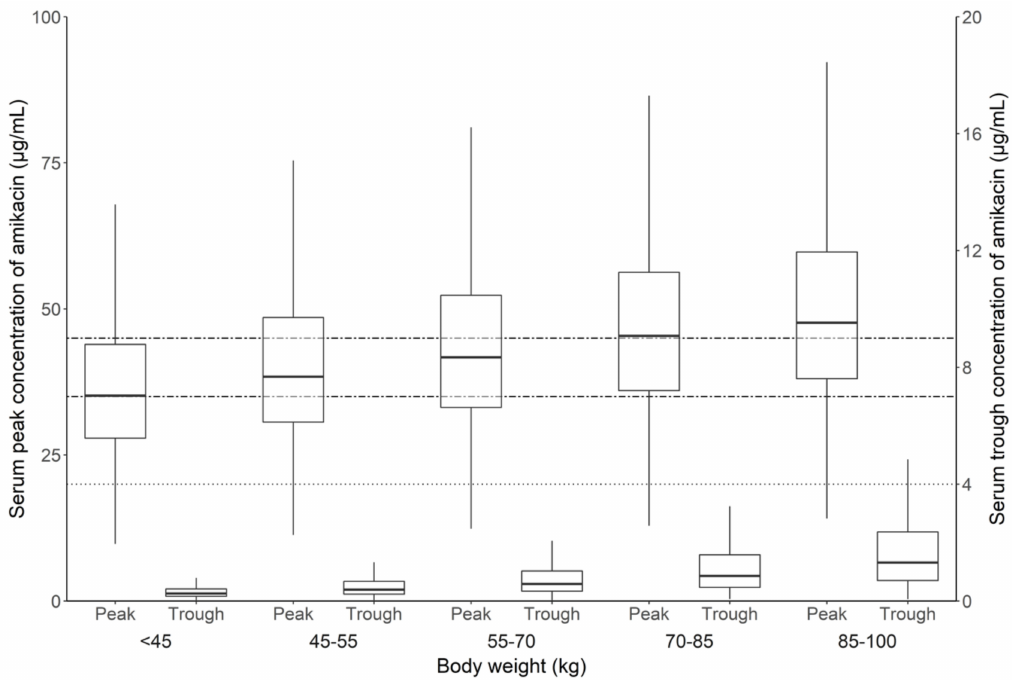
Figure 4. Box plot of predicted amikacin concentration following five times amikacin intravenous administration with 12 mg / kg once daily dosing regimen in various body weight patients with normal renal function. The dotted line represents the therapeutic range of C trough ( < 4 µ g / mL); the dot-dashed lines represent the therapeutic range of C peak (35–45 µ g /